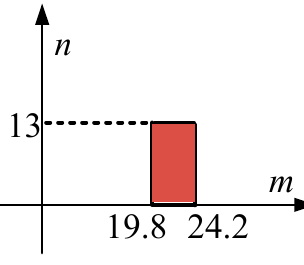
Figure 16. The stable region for droop parameters in the MG.